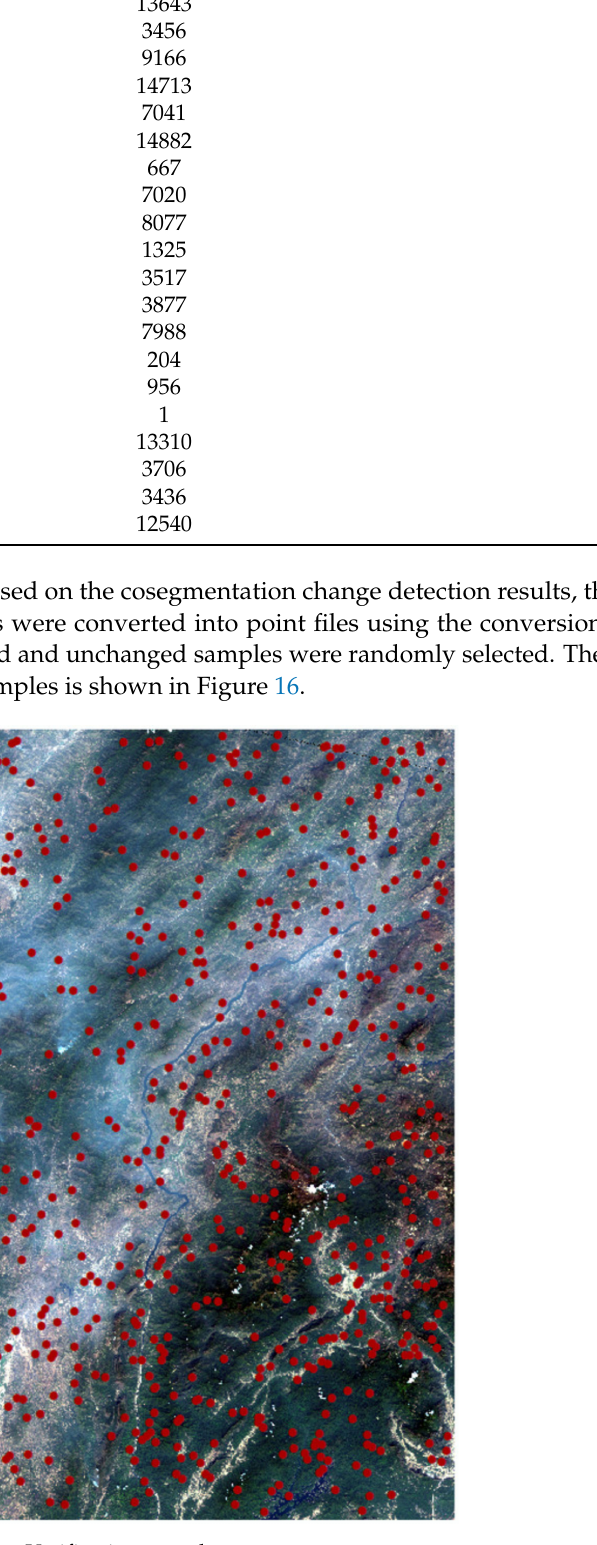
Figure 16. Verification